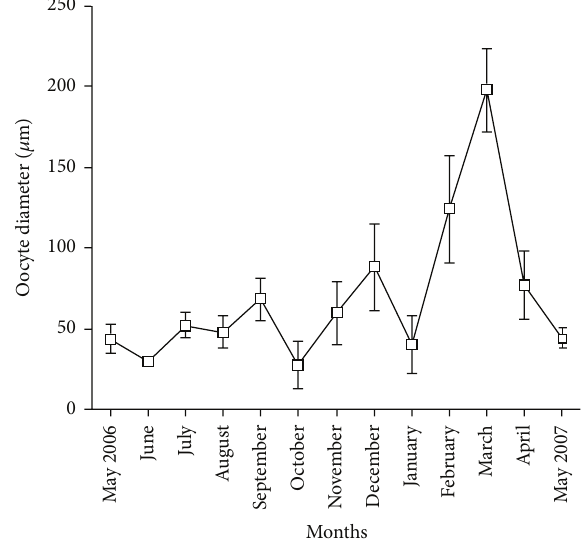
Figure6: Evolution ofoocyte sizefromMay 2006 to May 2007. Each data represents mean ± standard error of the mean (SEM).